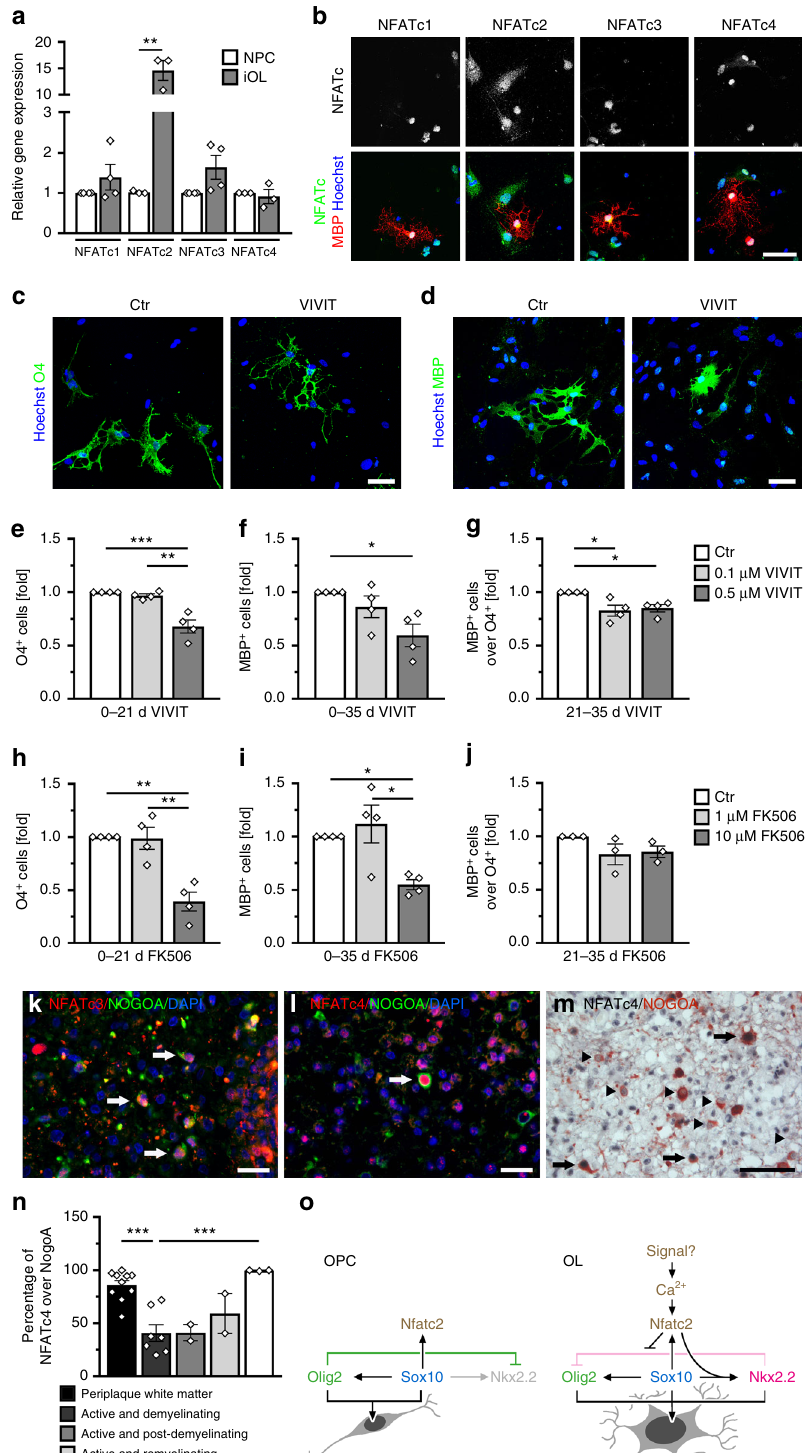
ECRs from the Nkx2 .2 and Nfatc2 genes had the following positions in Mm10: ECR115 chr2:147,308,082-147,306,872, ECR19 chr2:147,205,927-147,204,621, ECR5 chr2:147,181,491-147,180,670, ECR45 chr2:147,133,155-147,132,254, and ECR87 chr2:168,504,367-168,503,673. All ECRs were obtained by PCR from mouse ES cell DNA and inserted into the pGL2 luciferase reporter plasmid in front of a β - globin minimal promoter. Luciferase reporter plasmids with regulatory